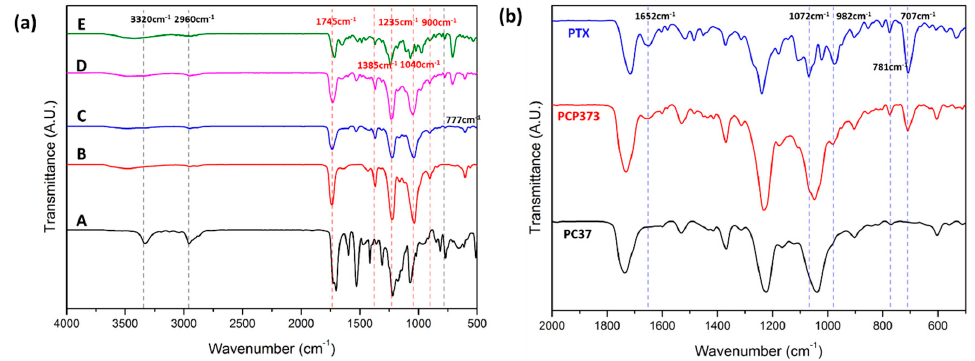
Figure 3. ( a ) Drug release behavior of PU/PC73/PC37 nanofibrous membrane with Paclitaxel (PTX). ( b ) Thermogravimetric analysis (TGA) curves of different composite nanofibers. Polymers 2019 , 11, x FOR PEER REVIEW